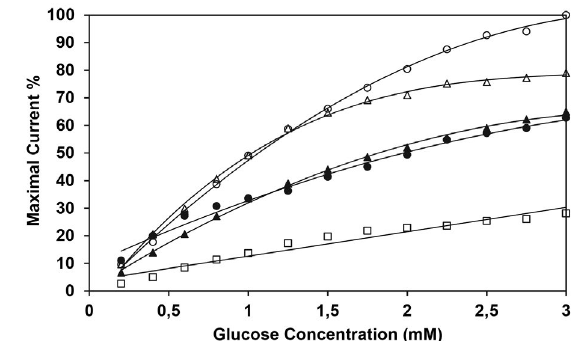
Figure 1. The effect of pyrrole concentration, that was used for PPy based electrode construction, on current values. Pyrrole concentra- tions: 10 mM (  ); 25 mM (  ); 50 mM (  ); 75 mM (  ) and 100mM (  ).